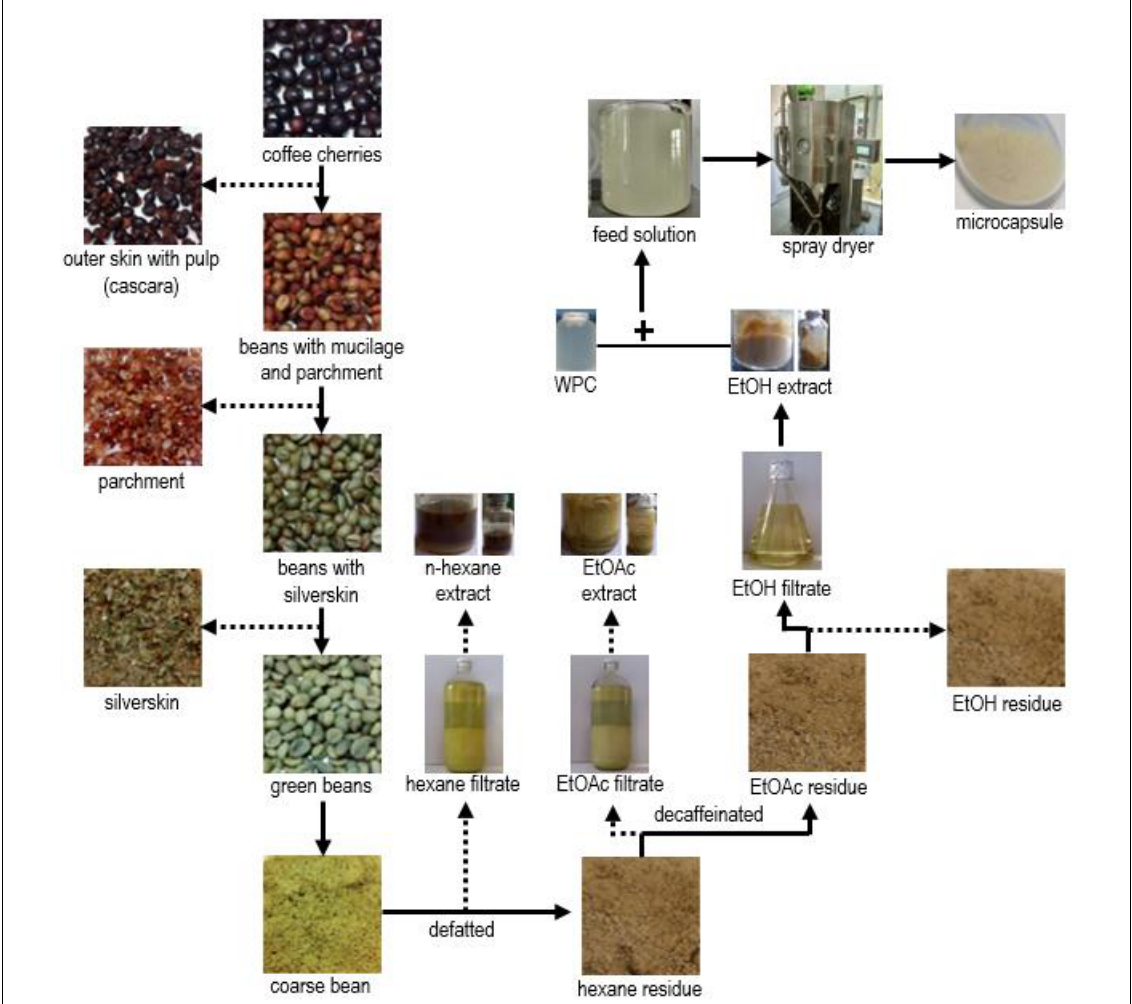
Figure 1. Scheme of GCB preparation, extraction, and microencapsulation process. The extraction was macerated gradually using n-hexane (defatted), ethyl acetate (decaffeinated), and ethanol solvents (analytical grade). Microencapsulation performed by processing the feed solution (200 µg/mL) containing extract (100 mg) and WPC (0.1%) using a spray dryer (180 °C inlet temperature, 70 °C outlet temperature, and 5 mL/min feed flow rate). EtOAc: ethyl acetate; EtOH: ethanol; WPC: whey protein